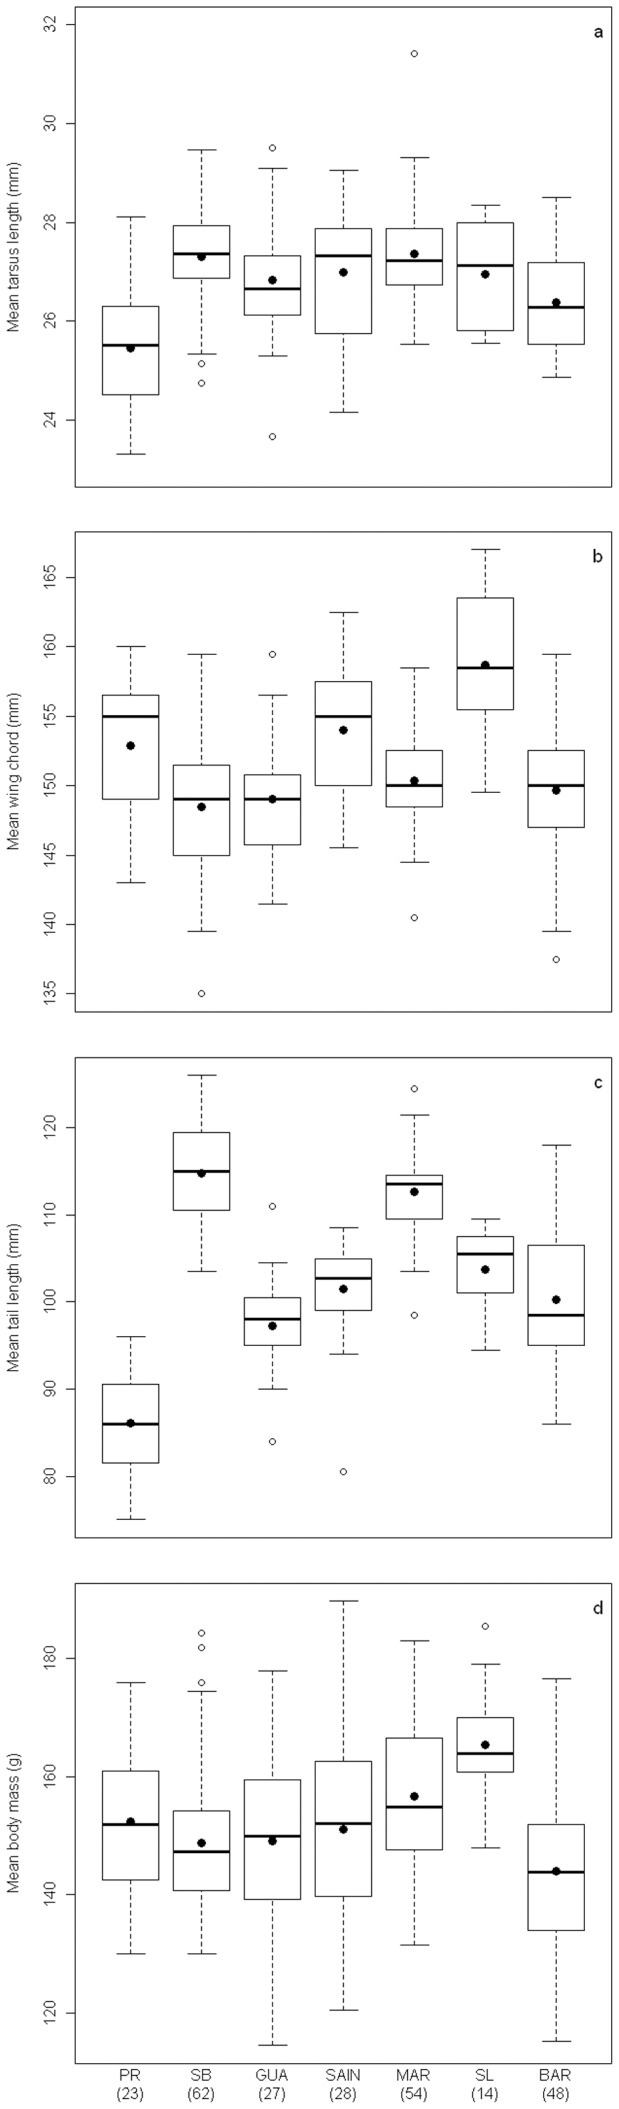
Morphological differences between islands in adult Zenaida Doves.a) tarsus length, b) wing chord, c) tail length and d) body mass. Boxes, plain line, black points, dash lines and open circles represent 50% of all values, medians, means, 1.5 x interquartile ranges and extreme values respectively.